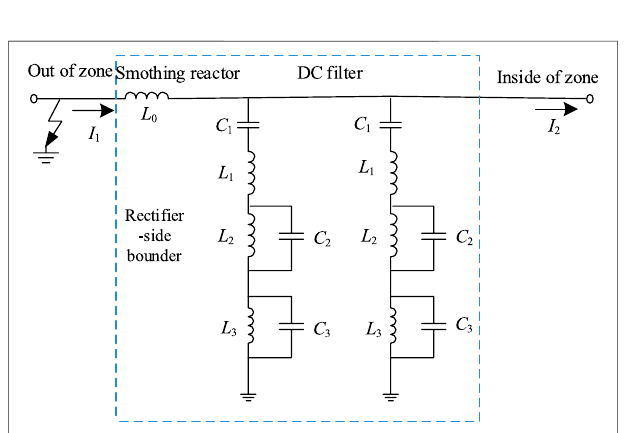
FIGURE 2 | Recti fi er-side boundary elements.